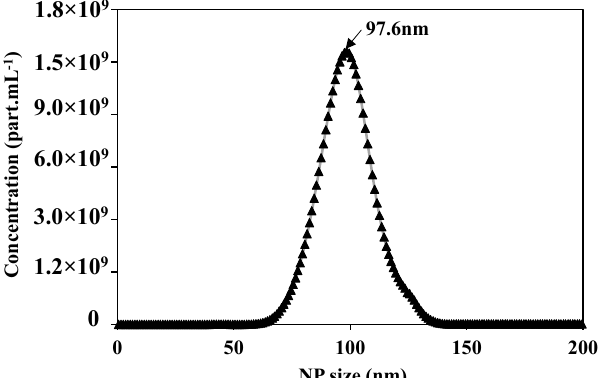
Figure 4. Concentration distribution for each NP size of suspension of NPs100 nm using the Nanosight N300 analytical technique.